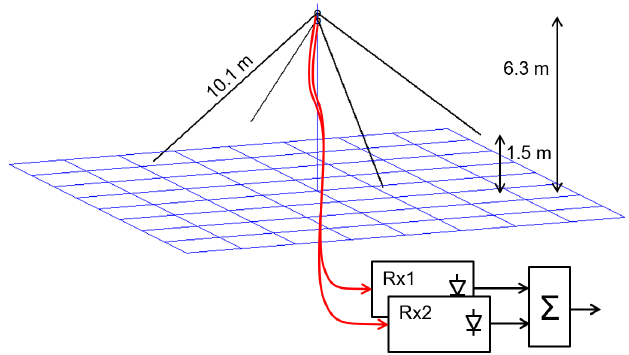
Figure 5. A hybrid antenna-receiver system that is omnidirectional and equally sensitive to all polarizations [24]. The power output of each dipole antenna is measured first, then their value is summed.